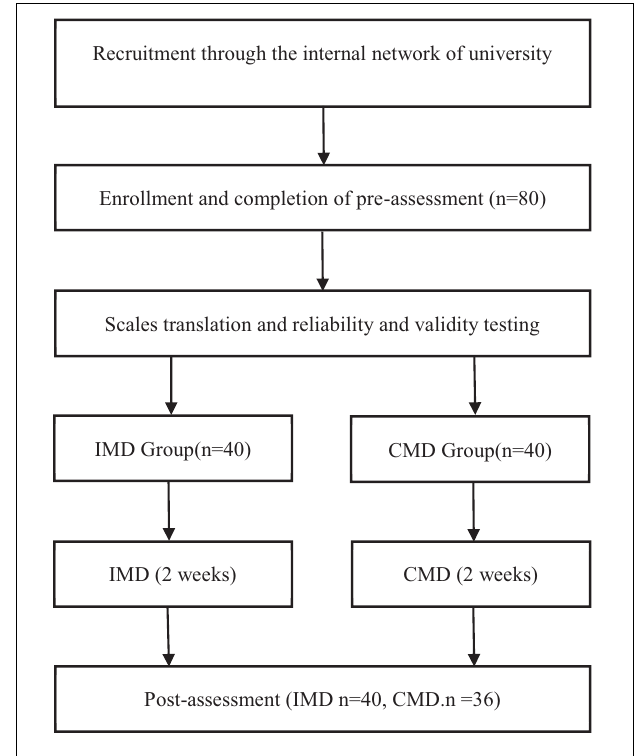
FIGURE 1 | Procedure flowchart. The mean value, standard deviation, and Pearson correlation matrix were used to analyze the data at the description level, and paired-sample t- tests was used to analyze the data at the inferential level. The sample size recruited matched or exceeded that of previous studies. Data were analyzed using SPSS version 22 (IBM, 2013), and the significance threshold was set to p <